Question: Condense the content of this figure into a single sentence.
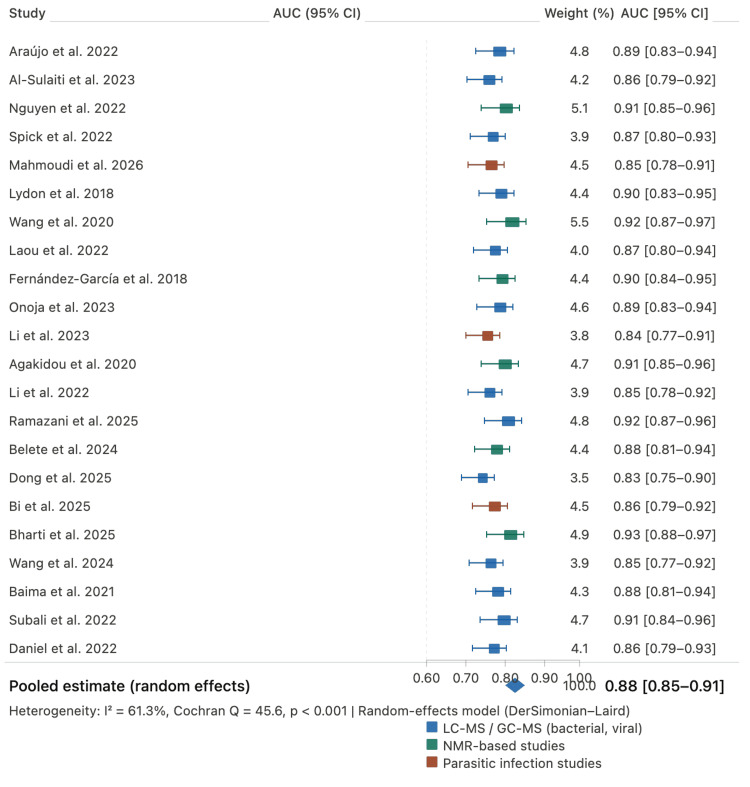
Answer: Forest plot of diagnostic accuracy: AUC of metablomics biomarkers for infectious disease detection References: [ 1 - 22 ]